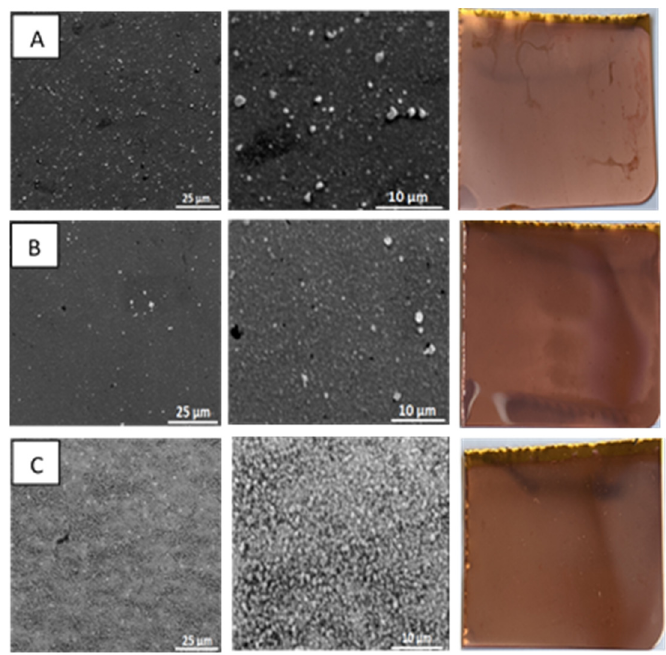
Figure 4. Electrodeposition of copper on brass/Ni(~20 μ m)/Au(~0.5 μ m) substrate performed